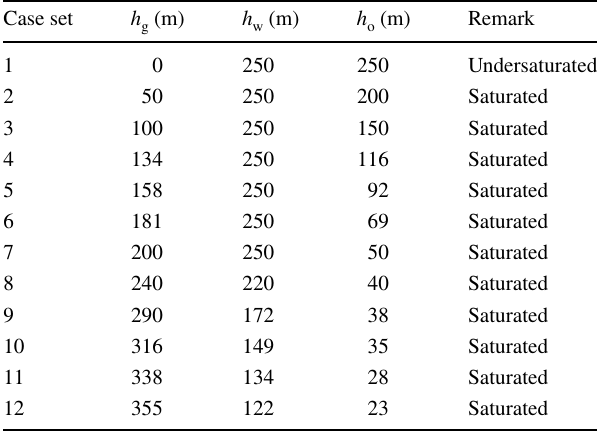
Table 1 Initial fluid distribution for all case sets (total model